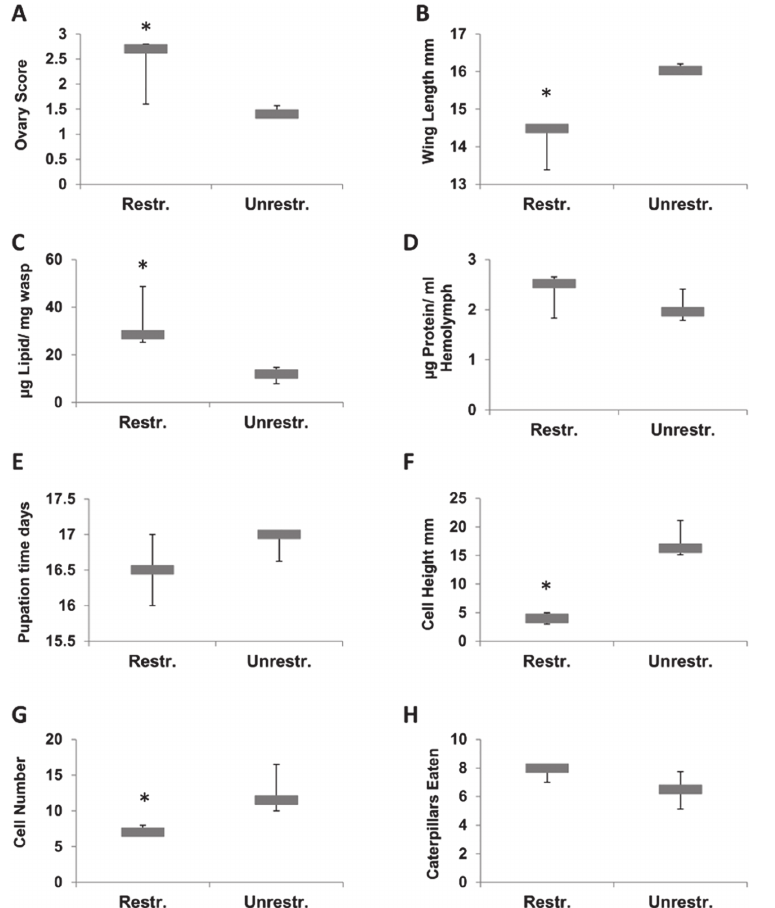
Fig 2. Medians (box) and quartiles of A) ovary score (N Res = 8, N Unres = 10 colonies), B) wing length (N Res = 9, N Unres = 10 colonies), C) gaster lipid levels (N Res = 8, N Unres = 10 colonies), D) hemolymph protein levels (N Res = 7, N Unres = 10 colonies), E) Number of days in pupation (N Res = 9, N Unres = 10 colonies), F) Pupal cocoon height (N Res = 9, N Unres = 10 colonies), G) number of cells in the nest (N Res = 9, N Unres = 10 colonies), and H) number of caterpillars eaten in two weeks by emerged wasps (N Res = 9, N Unres = 10 colonies). An “ * ” indicates cases in which the trait value in wasps from the restricted diet was significantly different from the trait values of wasps from the other two diets (Kruskal-Wallis Test, MCP). Wasps fed on ad libium and supplemented diets did not differ for any of the traits